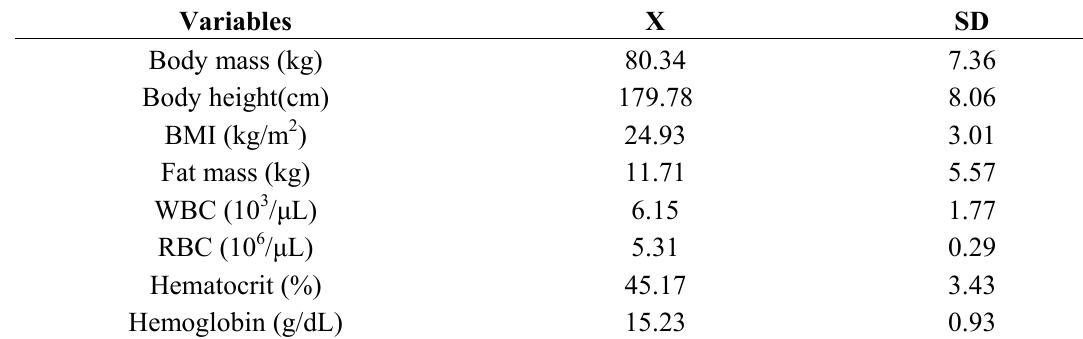
Table 1. The somatic and morphological characteristics of off-road cyclists taking part in the